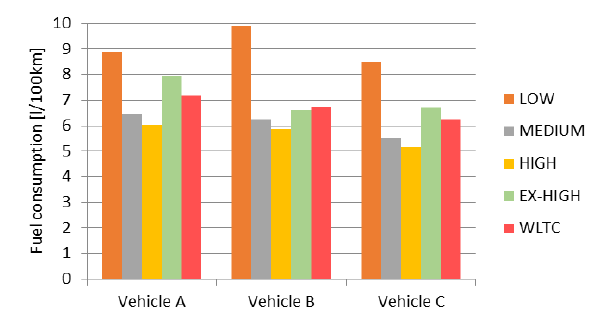
Fig. 7. Fuel consumption in WLTC test and its particular